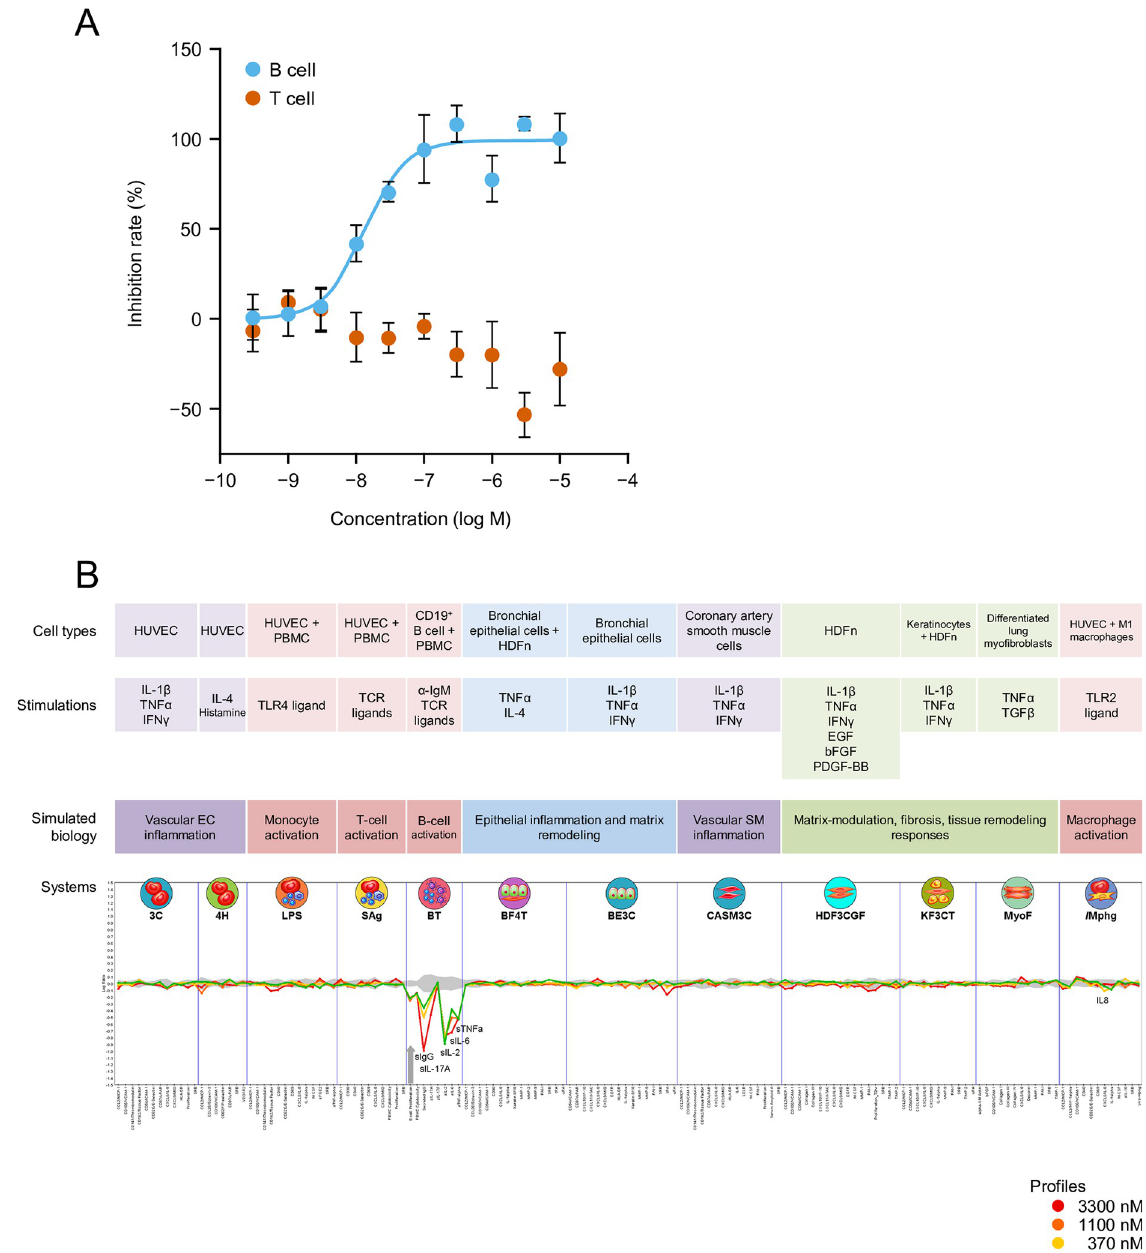
Fig 2. Selectivity of tirabrutinib in in vitro cellular systems. (A) PBMC activation assays. (B) BioMAP evaluation. (A) Effect of tirabrutinib on B and T cells activation. Human peripheral blood mononuclear cells were treated with vehicle or tirabrutinib, stimulated with anti-IgM or anti-CD3/CD28 antibodies, and labelled with fluorescent anti-CD3, anti-CD20, and anti-CD69 antibodies. After separation by flow cytometry, mean fluorescence intensity of CD69 in each cell population was measured. Values are the mean inhibition rate of three samples ± standard error. (B) The X-axis lists the quantitative protein-based biomarker readouts measured in each system. The Y-axis represents a log-transformed ratio of the biomarker readouts for the tirabrutinib-treated sample (N = 1) over vehicle controls (N � 6). The grey region around the Y-axis represents the 95% significance envelope generated from historical vehicle controls. Biomarker activities are annotated when two or more consecutive concentrations change in the same direction relative to vehicle controls, are outside the significance envelope, and have at least one concentration with an effect size > 20% (|log10 ratio| > 0.1). The thick grey arrow denotes antiproliferative effects, which only require one concentration to meet the indicated threshold for profile annotation. bFGF, basic fibroblast growth factor; EGF, epidermal growth factor; HDFn, human neonatal dermal fibroblasts; HUVEC, human umbilical vein endothelial cells; IFN, interferon; Ig, immunoglobulin; IL, interleukin; PBMC, peripheral blood mononuclear cells; PDGF, platelet-derived growth factor; TCR, T-cell receptor; TGF, transforming growth factor; TLR, Toll-like receptor; TNF, tumor necrosis factor.